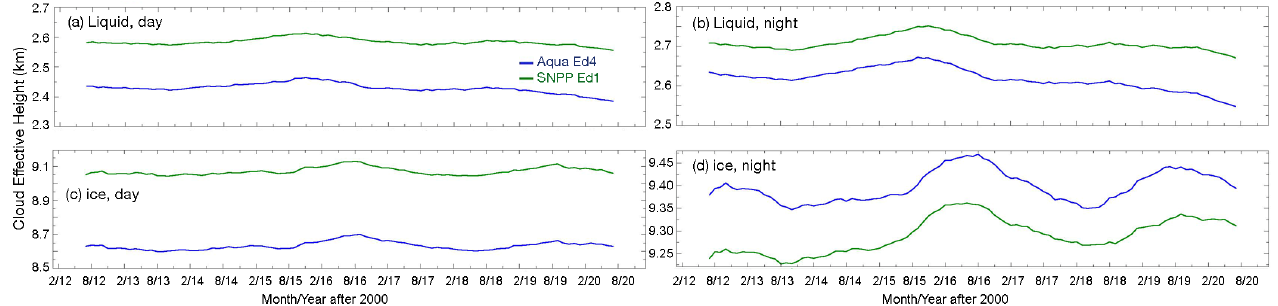
Figure 9. Same as Figure 6, except for the mean liquid ( top ) and ice ( bottom ) cloud effective height for day ( left ) and night ( right ).